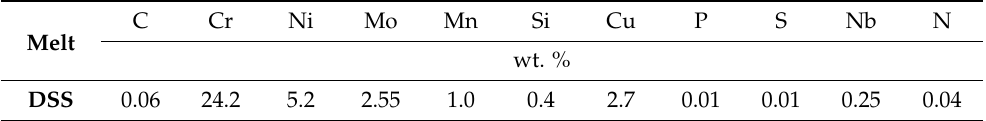
Table 1. Chemical composition of tested cast steel. Melt